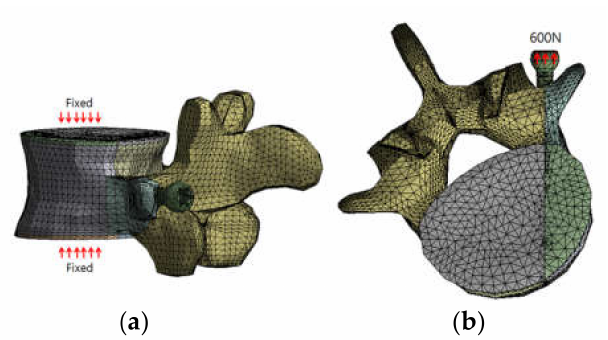
Figure 7. Simulation conditions: ( a ) the boundary conditions and ( b ) the loading conditions for the pull-out